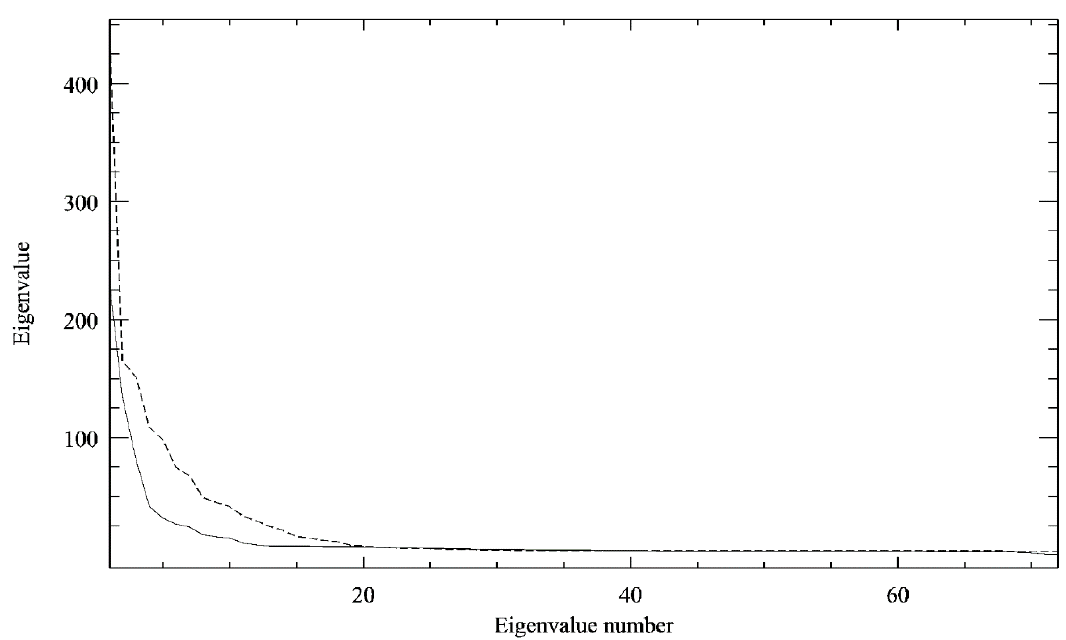
Figure 7. The profile of the Minimum Noise Fraction (MNF) Eigenvalues for the case of the entire strip (broken line) and the case of training areas only (solid line).